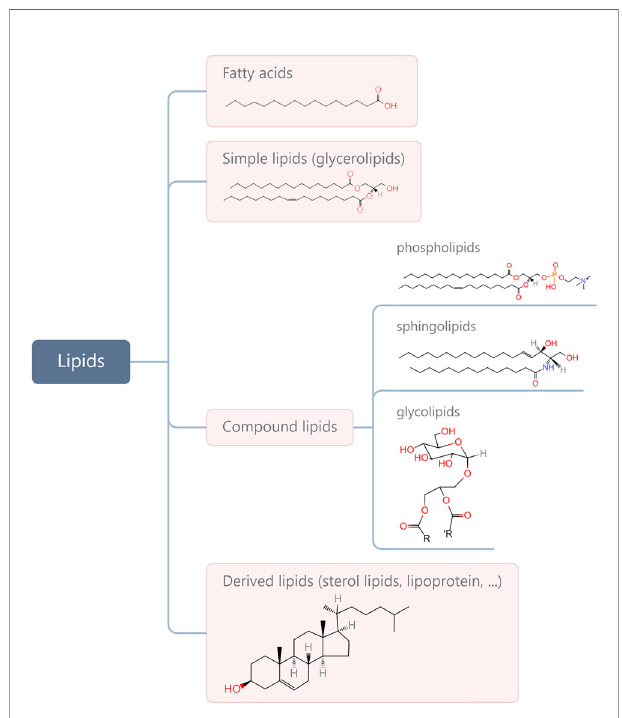
FIGURE 1 | Categories of main lipids involved in cellular processes and representative structures from each